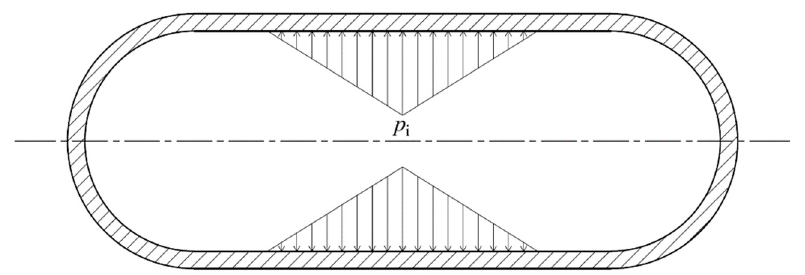
Figure 1. Geometrical model of a cylindrical shell subjected to a spindle-shaped load.